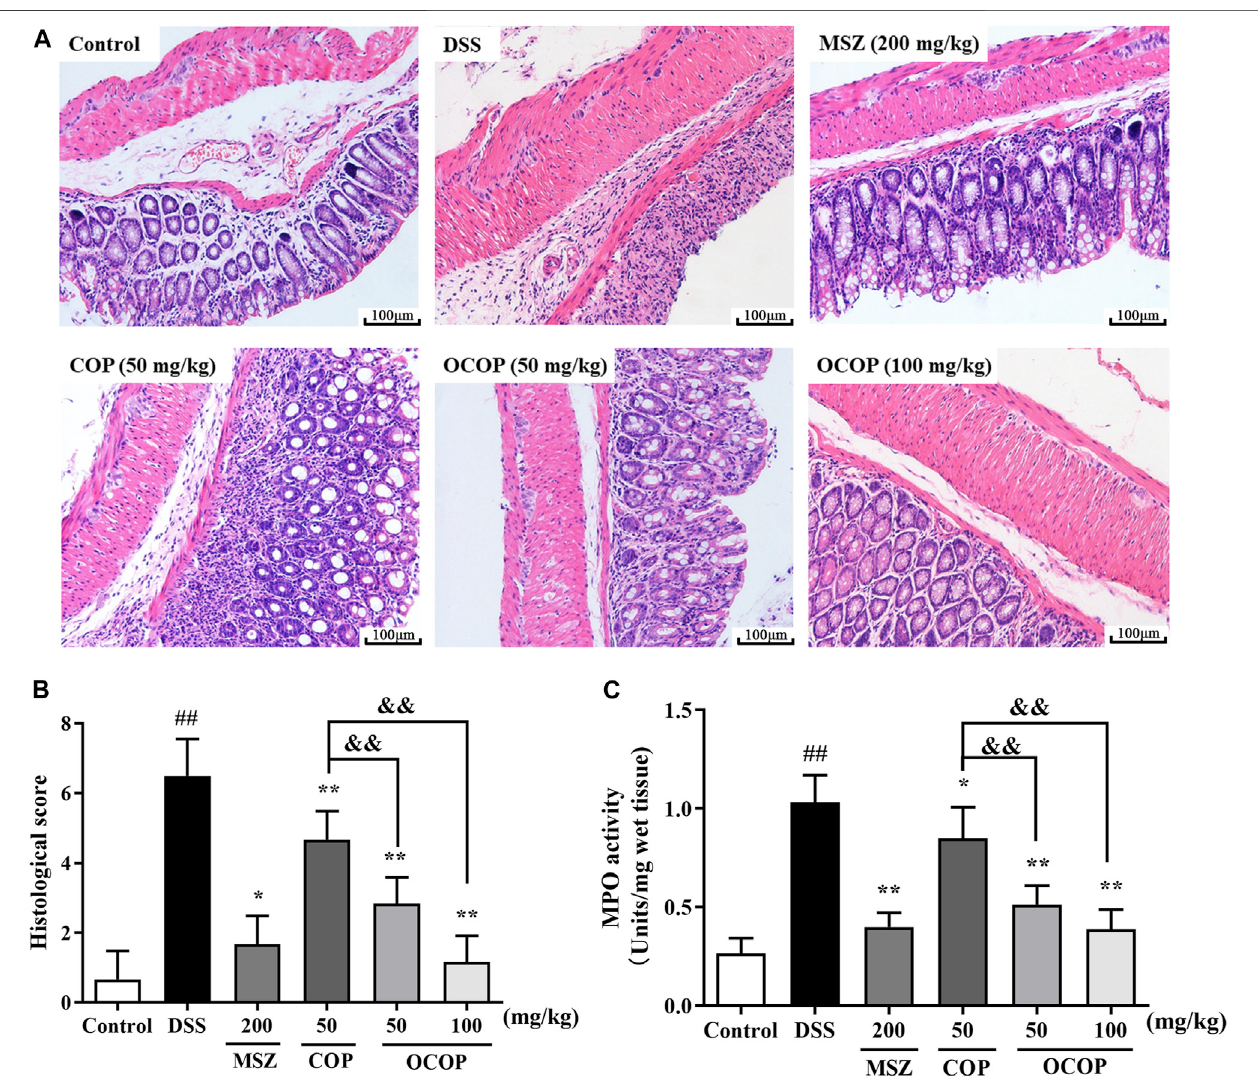
FIGURE 3 | (A) Representative colorectal slices of H&E staining. Original magni fi cation × 200. (A) control; (B) DSS; (C) MSZ; (D) COP (50 mg/kg); (E) OCOP (50 mg/kg); (F) OCOP (100 mg/kg) (B) Histological scores of each group (C) The MPO activity of colon tissues. Data are expressed as the means ± SD (n (cid:2) 6 – 8). # p < 0.05, ## p < 0.01 vs. control group; * p < 0.05, ** p < 0.01 vs. DSS group; & p < 0.05, && p < 0.01 vs. COP